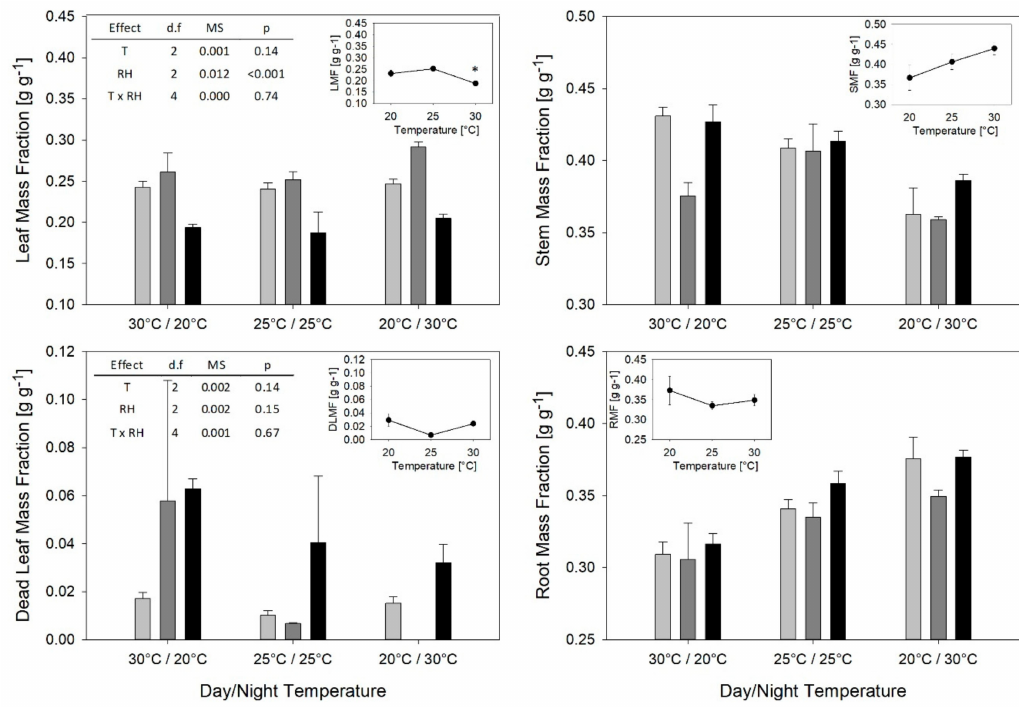
Figure 1. Leaf, stem, dead leaves, and root mass fractions after two weeks of varying day and night temperature and RH regimes. Light grey bars: RH day / night 40 / 90%; dark grey bars: RH day / night 65 / 65%; black bars: RH day / night 90 / 40%. Insert 1: Respective mass fractions at di ff erent constant day and night temperatures and constant 65% RH. Asterisk indicates significant di ff erence at p < 0.05. Insert 2: Analysis of variance for the respective mass fraction at di ff erent day and night temperature and RH regimes. In both, main figure and insert 1, mean values with standard errors ( n = 3) are presented. Abbreviations: T: temperature; d.f.: degrees of freedom; MS: mean